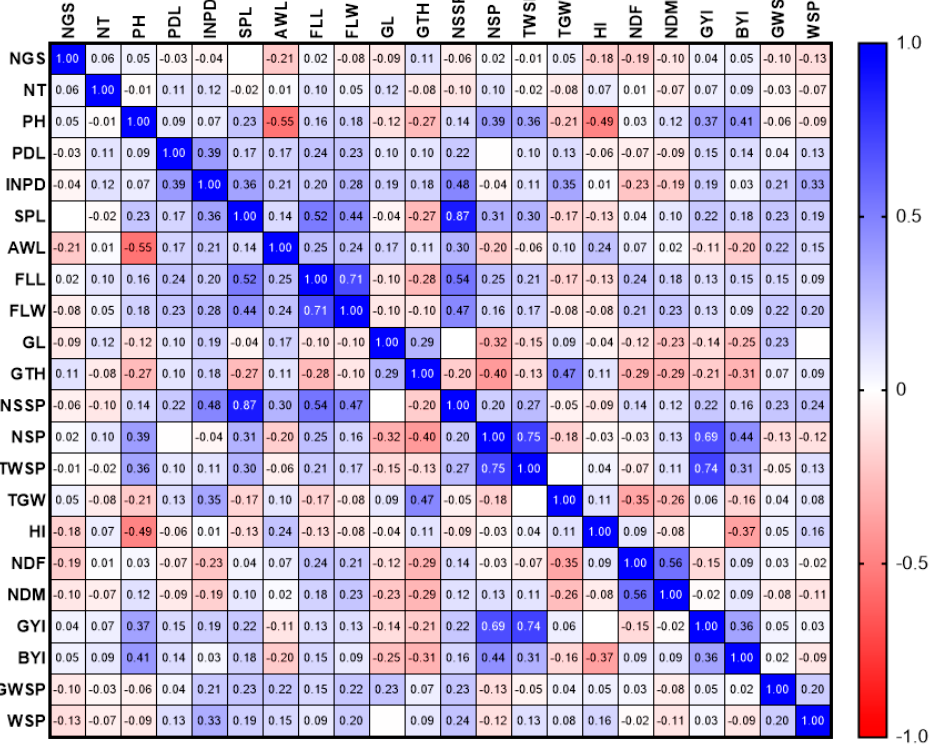
Figure 7. Correlation of study traits in F8 wheat lines resulting from Gonbad × Kohdasht in 2020.